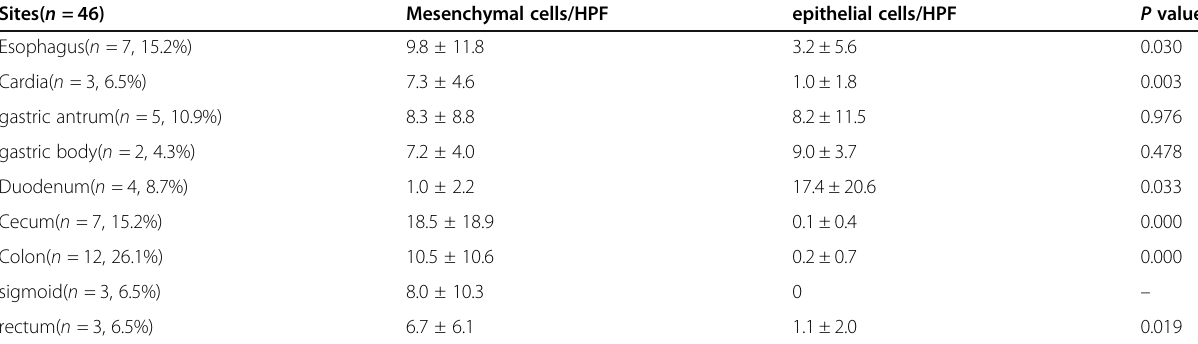
Table 2 cellular localization of CMV in gastrointestinal tract mucosal biopsies